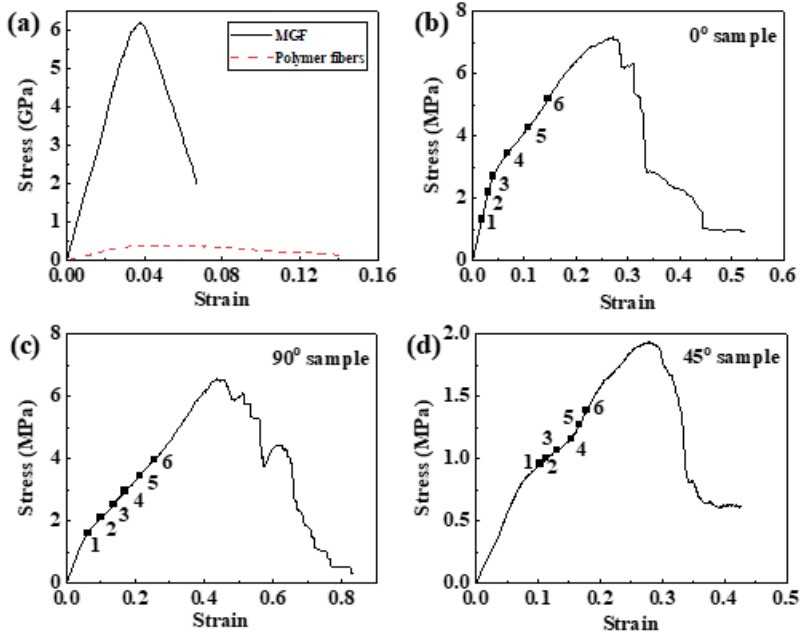
Figure 2. Tensile stress-strain curves of ( a ) MGF and polymer fiber, ( b ) 0 ◦ specimen, ( c ) 90 ◦ specimen, and ( d ) 45 ◦ specimen.